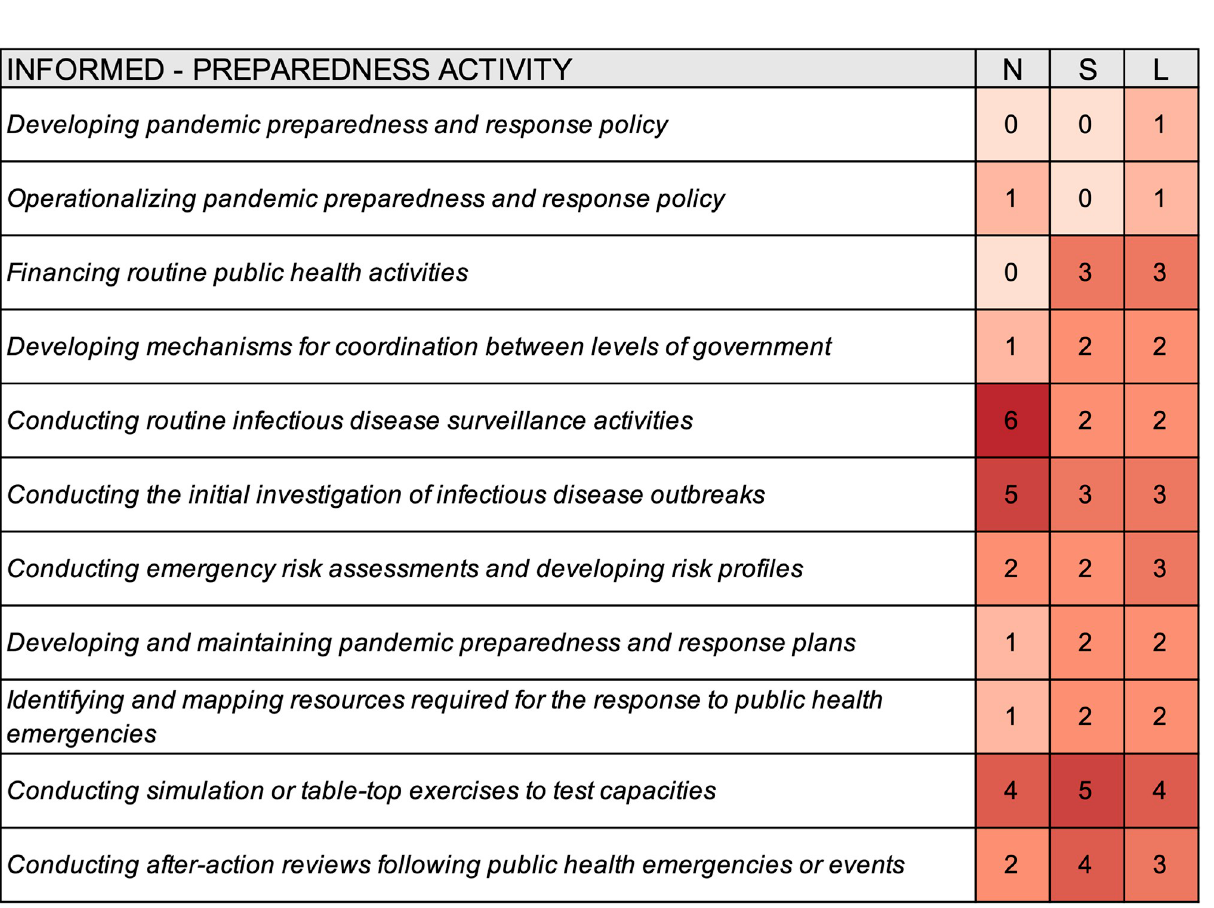
Fig 5. Heat map summarizing which levels of government are informed about select preparedness activities according to survey responses from thirty-three cities. N–National, S–Subnational,